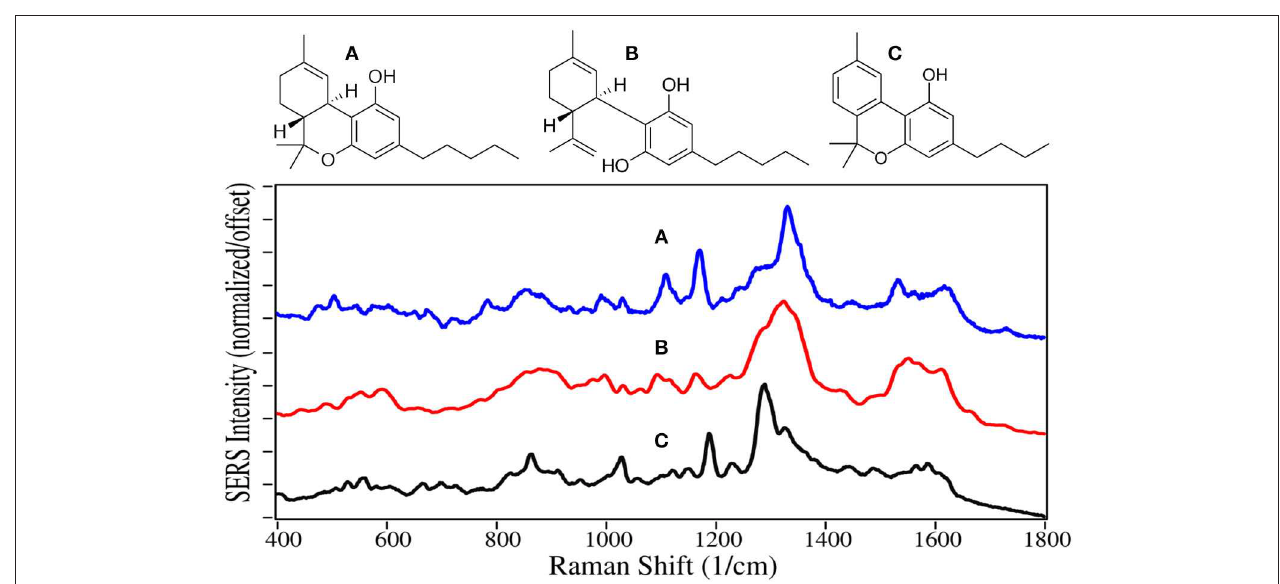
FIGURE 11 | Structures and 10 ppm SERS of (A) tetrahydrocannabinol, (B) cannabidiol, and (C) cannabinol.